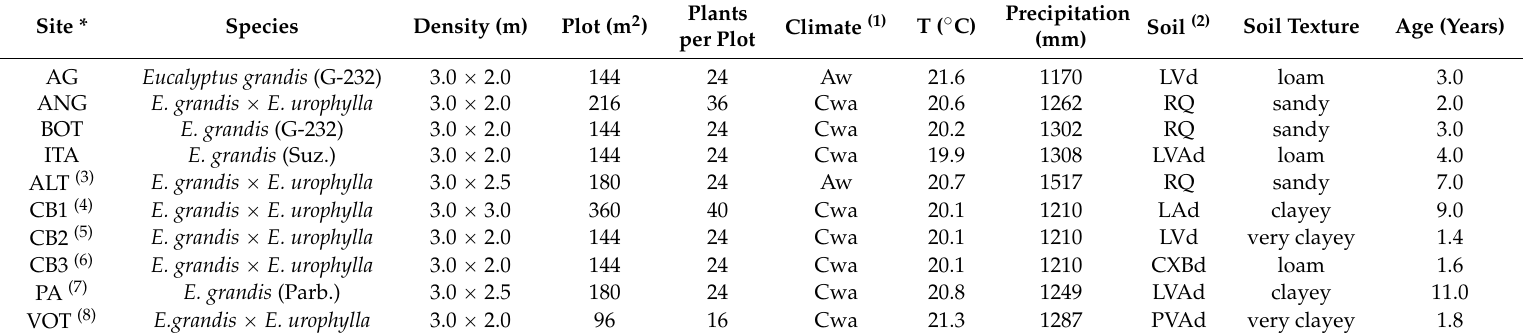
Table 1. Sites, species, plant density, climate types, soil orders, soil texture and age in Brazilian Eucalyptus plantations. Site * Species Density (m) Plot (m 2 )